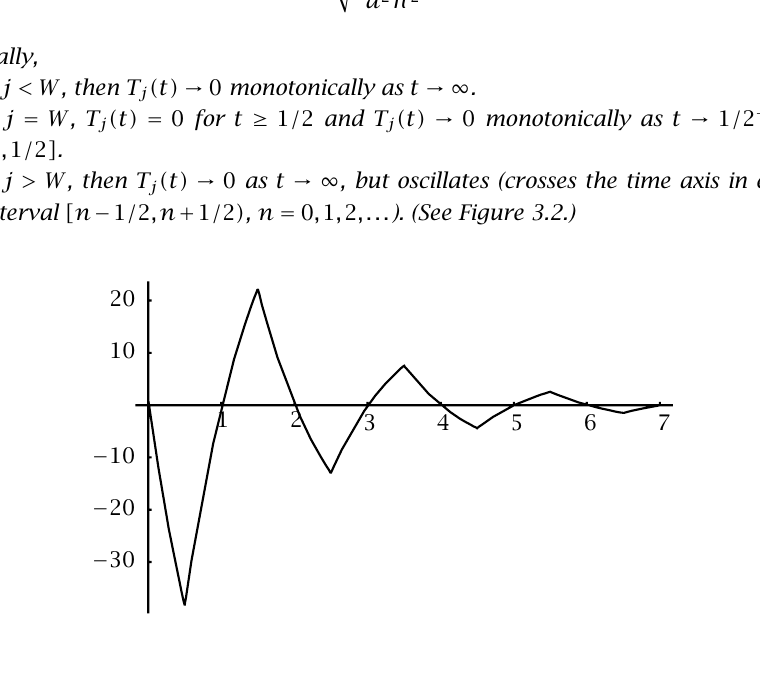
Figure 3.2 . T j (t) for b(t) = b , b = 0 . 99, j = 1, a = 1 /π